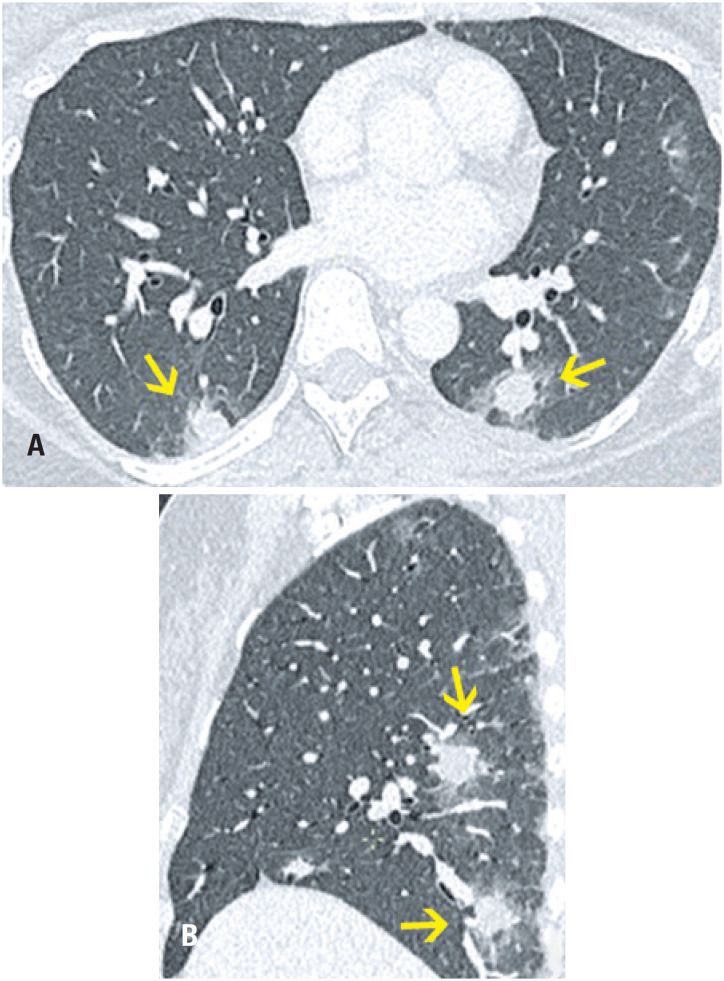
Paciente do sexo feminino, 39 anos, com queixa de tosse. Tomografia computadorizada (A) Axial (B) Reformatação sagital: múltiplos nódulos pulmonares com halo em vidro fosco disseminados pelos pulmões, maiores e mais numerosos nos campos médios e inferiores. Confirmado com sorologia para sarampo